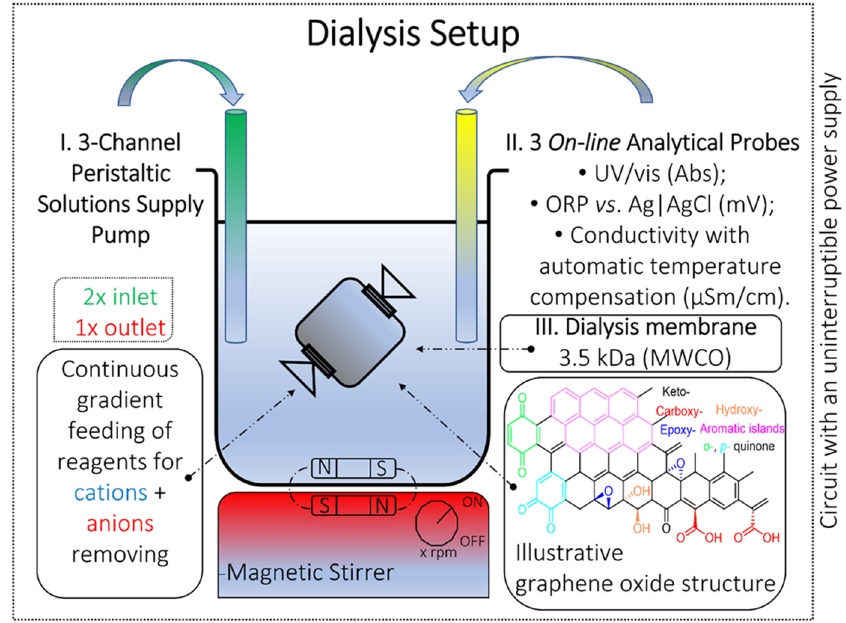
Figure 1. Schematic diagram of the dialysis setup